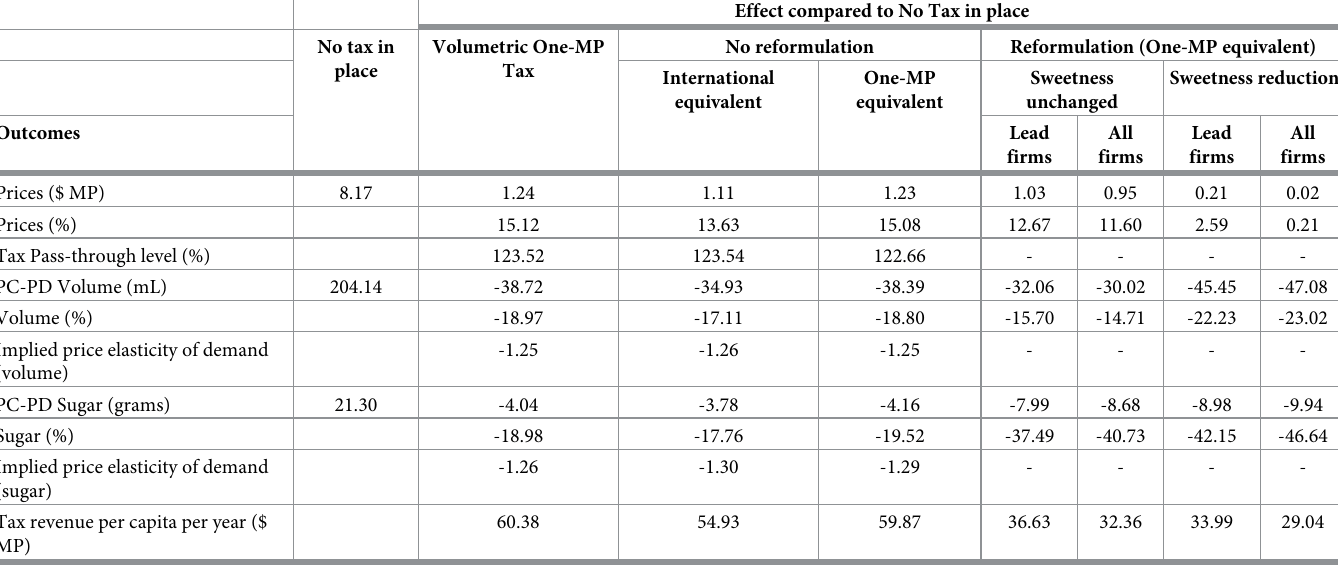
Table 4. Tax effect in 2014 and 2015: South-Africa tax